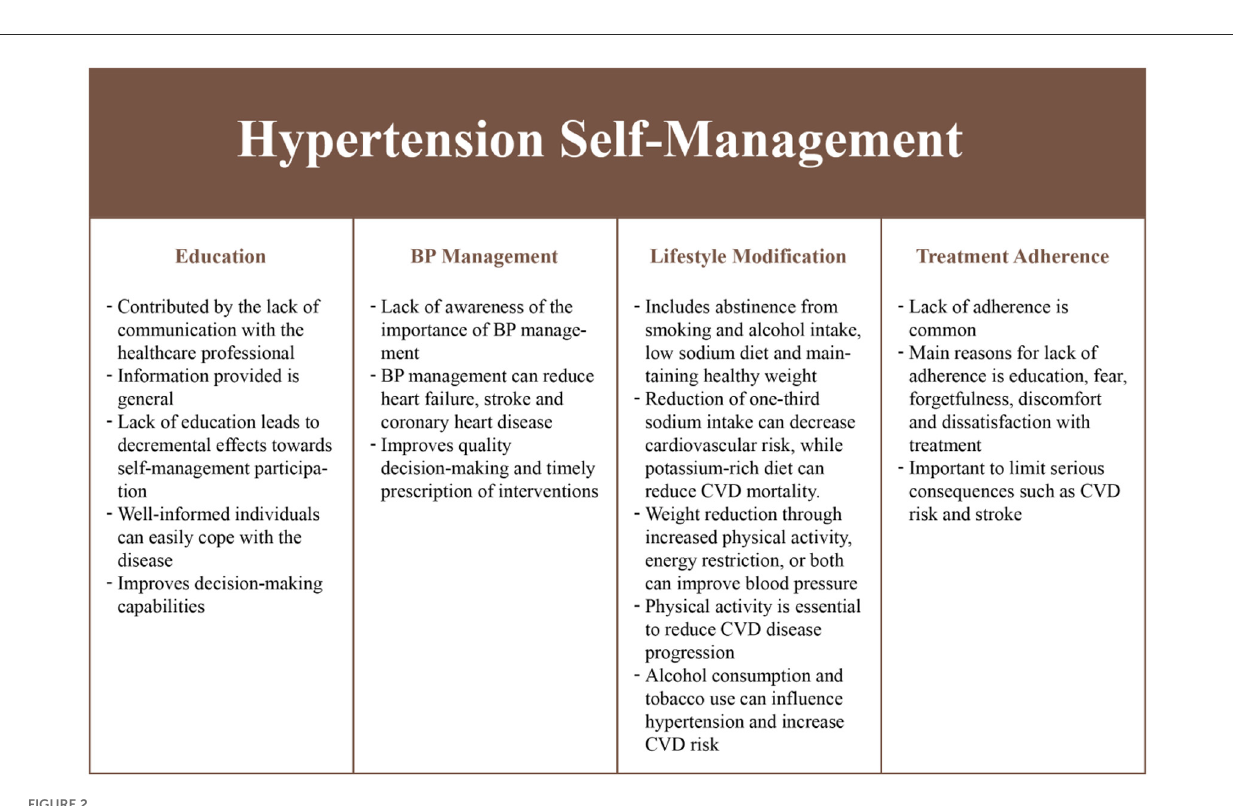
FIGURE2 Hypertension self-management